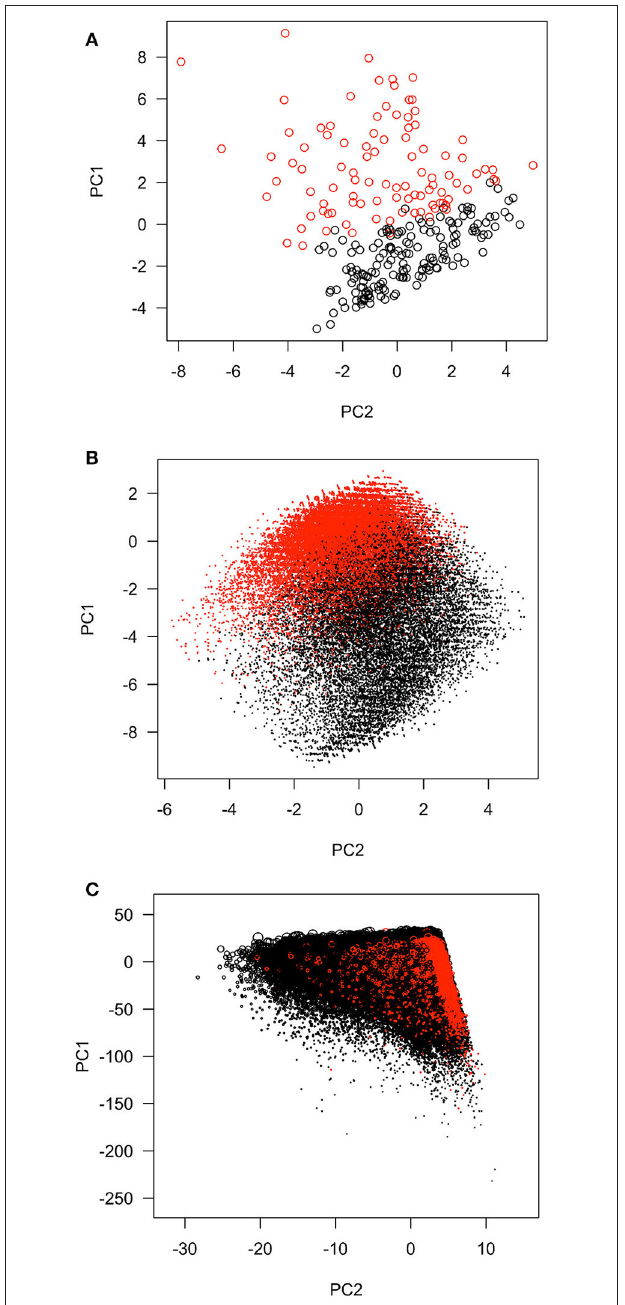
FIGURE 1 | The distributions of first two principal components of the data sets. (A) The Hitters data set. Red: observations with CRBI (career runs batter in, the variable first selected in the stepwise regression to approximate the first principal component) > 330; Black: observations with CRBI ≤ 330. (B) The MEPS SF-12 v2. subset. Red, observations with little or none of the time being limited in kind of work or other activities as result of physical health during past four weeks (variable name: adpwlm2, the variable first selected in the stepwise regression to approximate the first principal component); Black, some or most or all of the time being limited in kind of work or other activities. (C) The MEPS 1996–2011 panels. MEPS, Medical Expenditure Panel Survey; PC, principal component; SF-12v2, the Short-Form 12 Version 2. Red, subjects with the amounts of workers’ compensation larger than zero; Black, subjects without any workers’